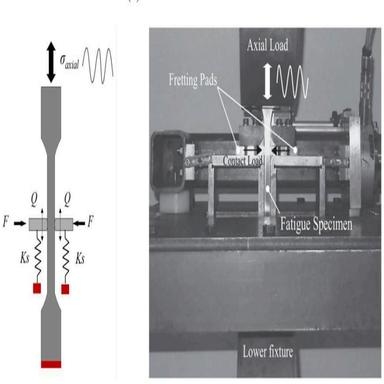
Fretting fatigue experiment: (a) a schematic of fretting fatigue experiment set-up and (b) the fretting fatigue test rig .